Question: What does this figure show? Answer in one sentence.
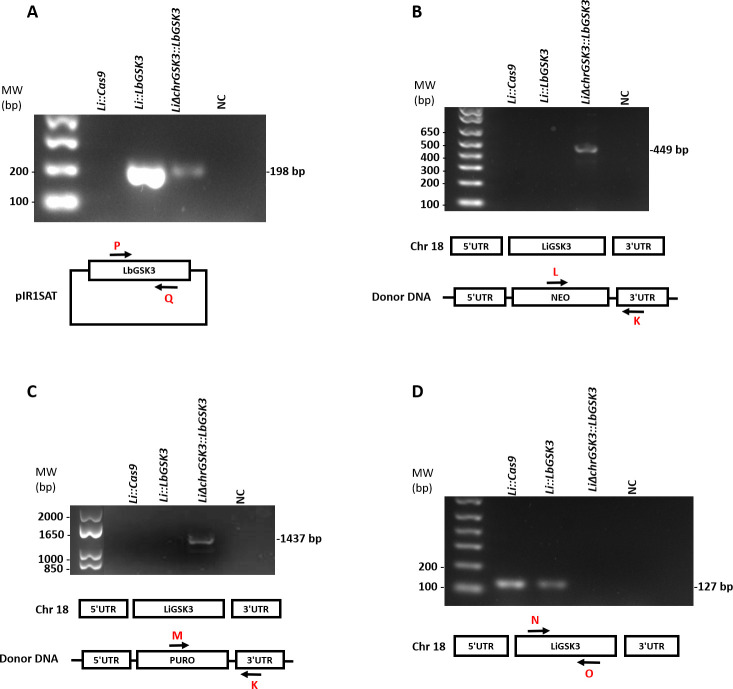
Answer: Chromosomal GSK-3s knockout in L. infantum expressing episomal L. braziliensis GSK-3s. First, the knockout was assessed by PCR using genomic DNA from Li::Cas9 and mutant parasites. ( A ) Confirmation of the presence of the episomal L. braziliensis GSK-3s gene. The correct integration of the ( B ) NEO and ( C ) PURO resistance markers was evaluated by PCR using one primer annealing to the 3′ UTR region of GSK-3 and another primer annealing to the resistance marker sequence. ( D ) Confirmation of the parasites knocked out for the chromosomal L. infantum GSK-3s gene. Please note that the schematic representations of the molecules are not to scale, with sizes and distances adjusted for clarity rather than accuracy. MW: molecular weight standard; bp: base pairs; NC: negative control.